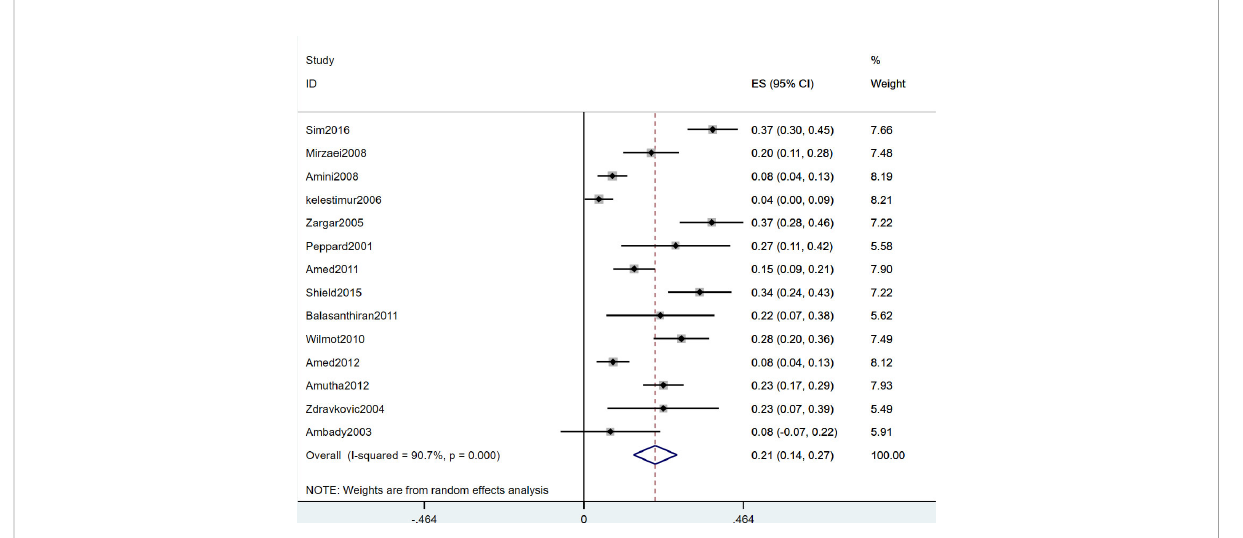
FIGURE 2 Forest Plot Showing Prevalence of PCOS in Patients With